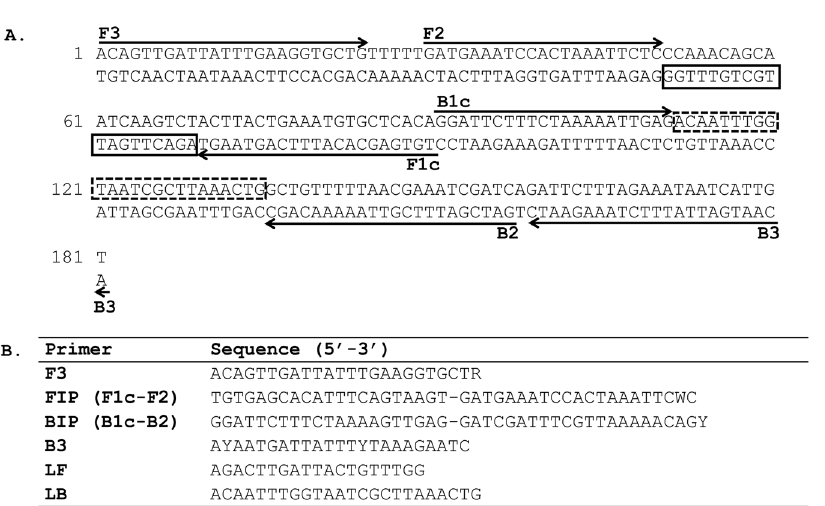
Figure 2. LAMP primer set targeting the M . perstans Mp419 repeat. ( A ) The location of the six LAMP primers within the consensus sequence is shown. Arrows indicate the direction of extension. The solid and dash line boxes represent the binding regions of the loop forward (LF) and loop back (LB) primers respectively. ( B ) Sequence of the LAMP primers. F3, FIP, BIP and B3 are degenerate primers where R = A or G, W = A or T and Y = C or